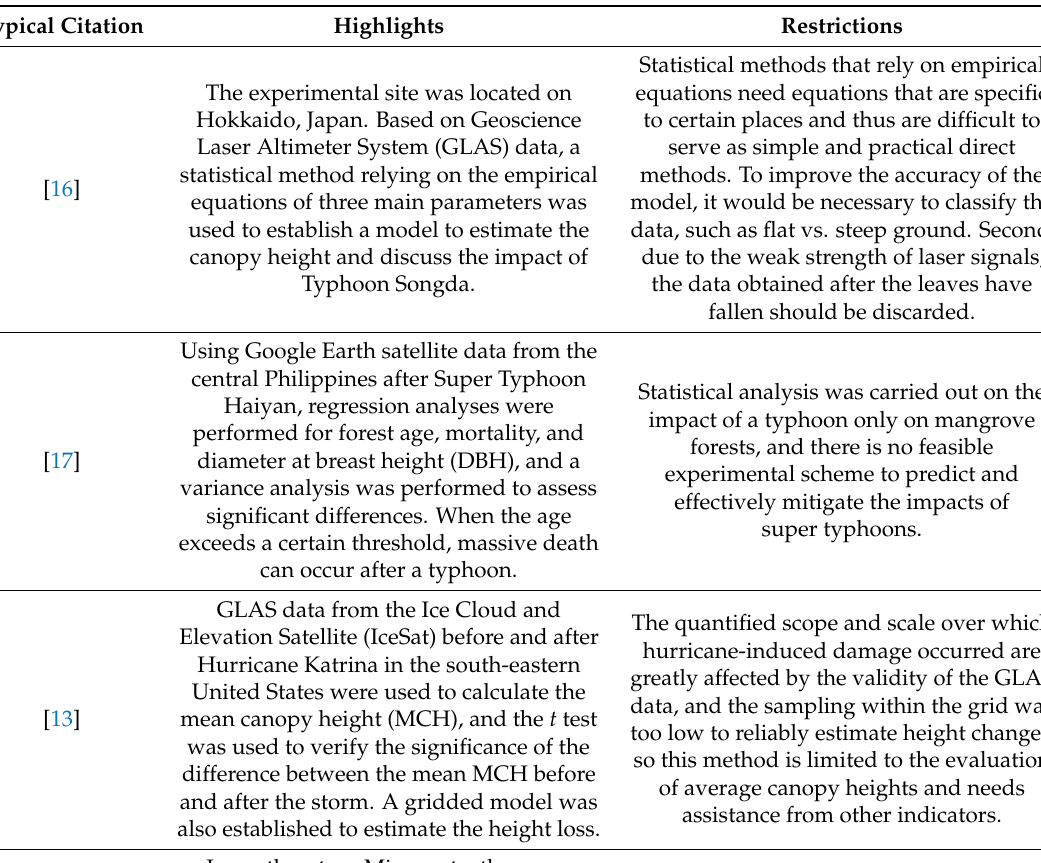
Table 1. Brief introduction to the existing methods for studying the damaging effects of wind on